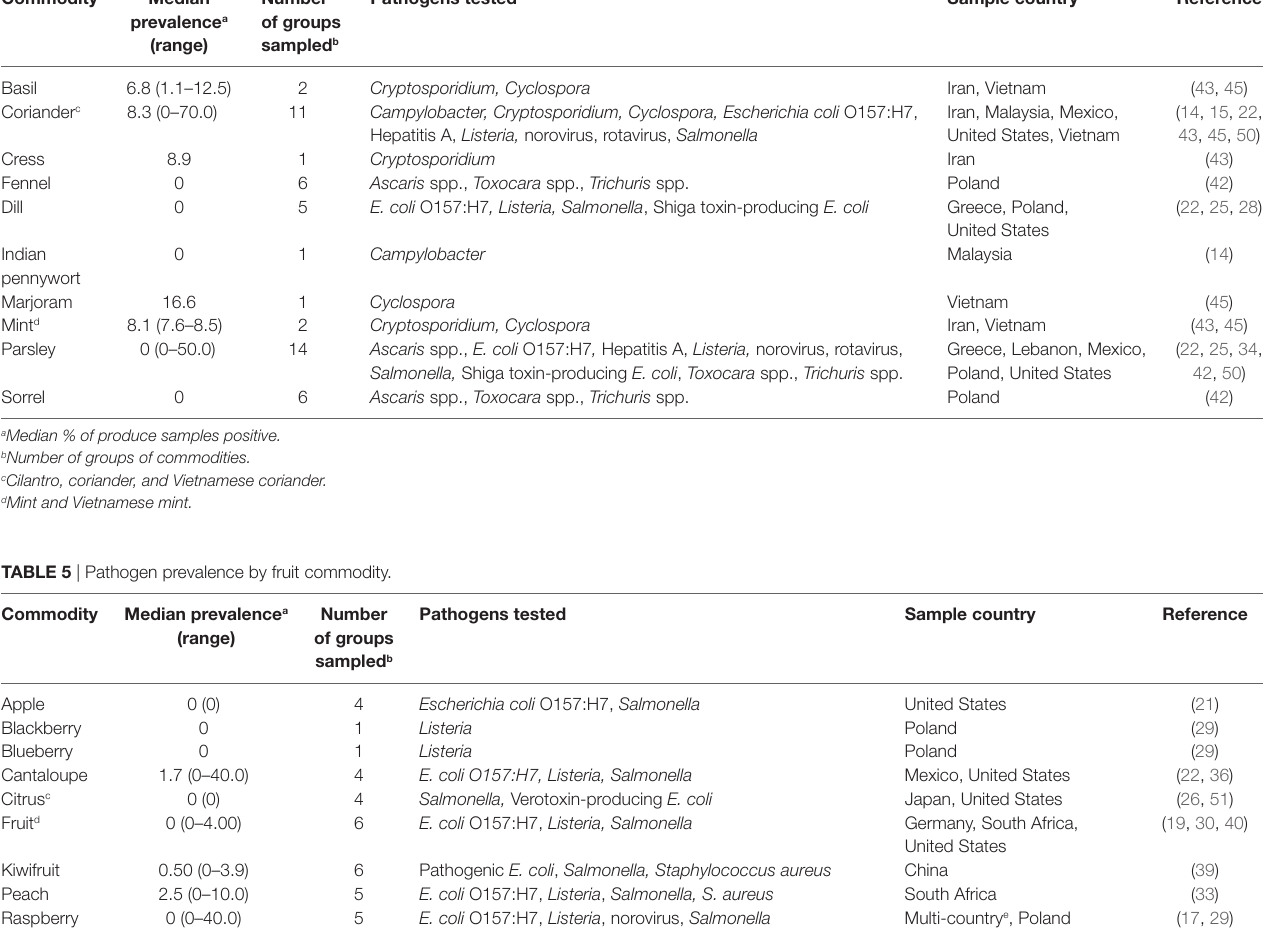
tabLe 4 | Pathogen prevalence by herb commodity. commodity